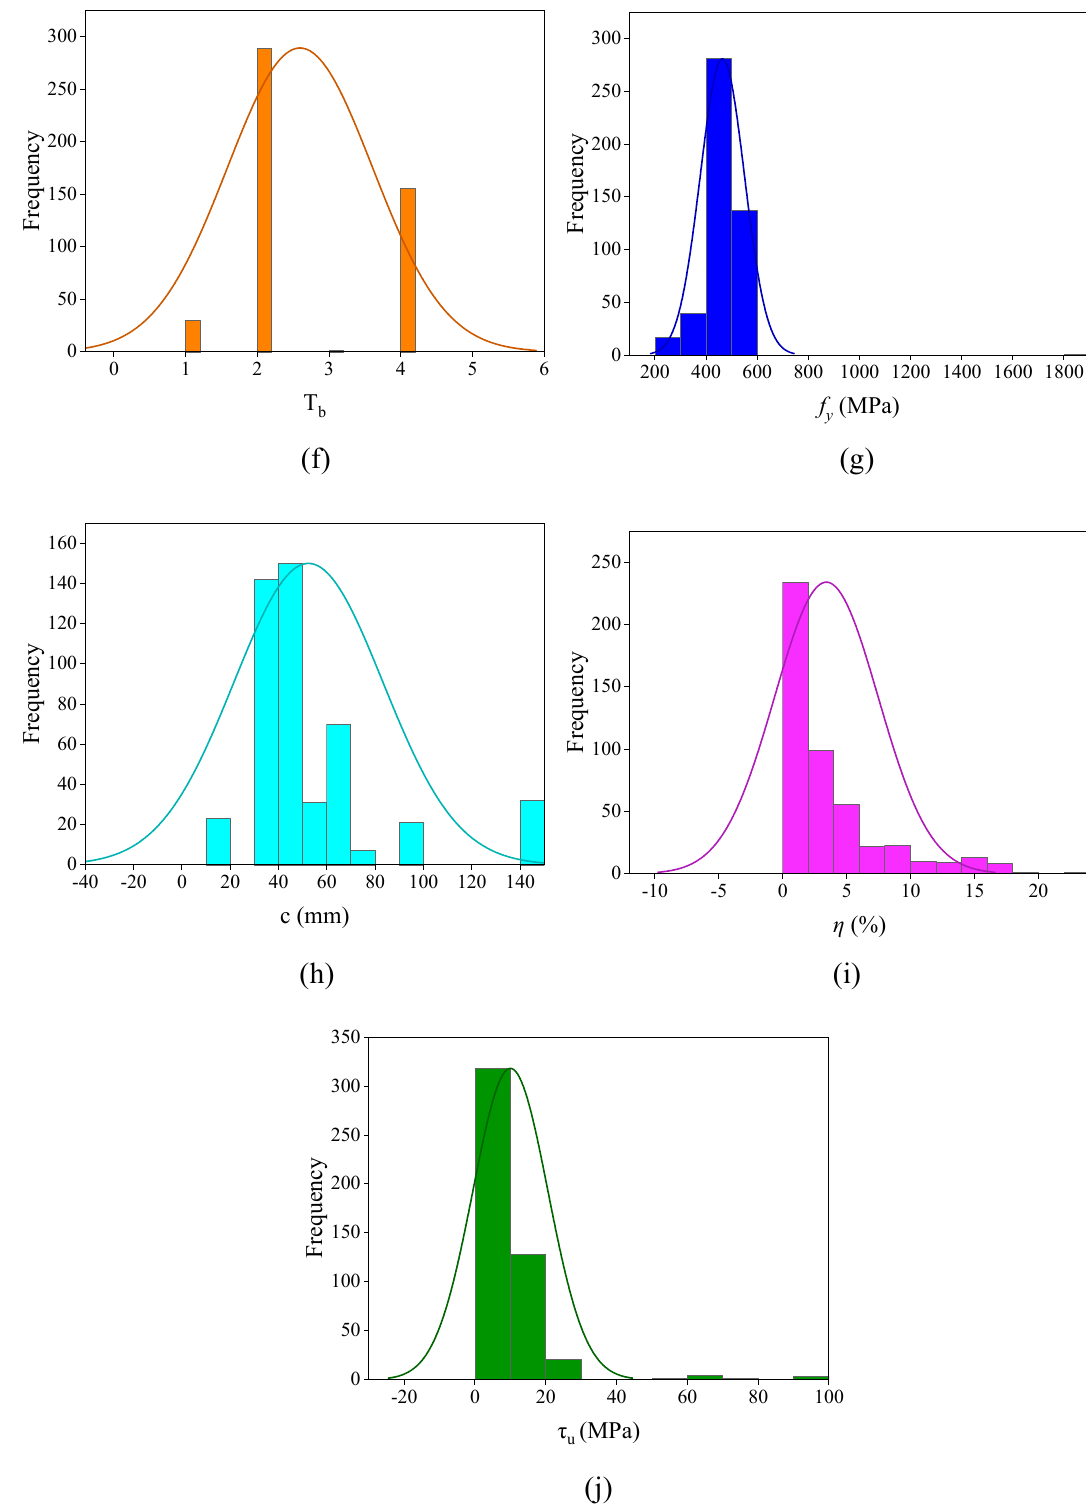
Figure 2. Cont Figure 2. Relative frequency distribution of input and output parameters; ( a ) S AS , ( b ) w/c , ( c ) f ’c , ( d ) L b , ( e ) d , ( f ) T b , ( g ) f y , ( h ) c , ( i ) η , ( j ) τ u .